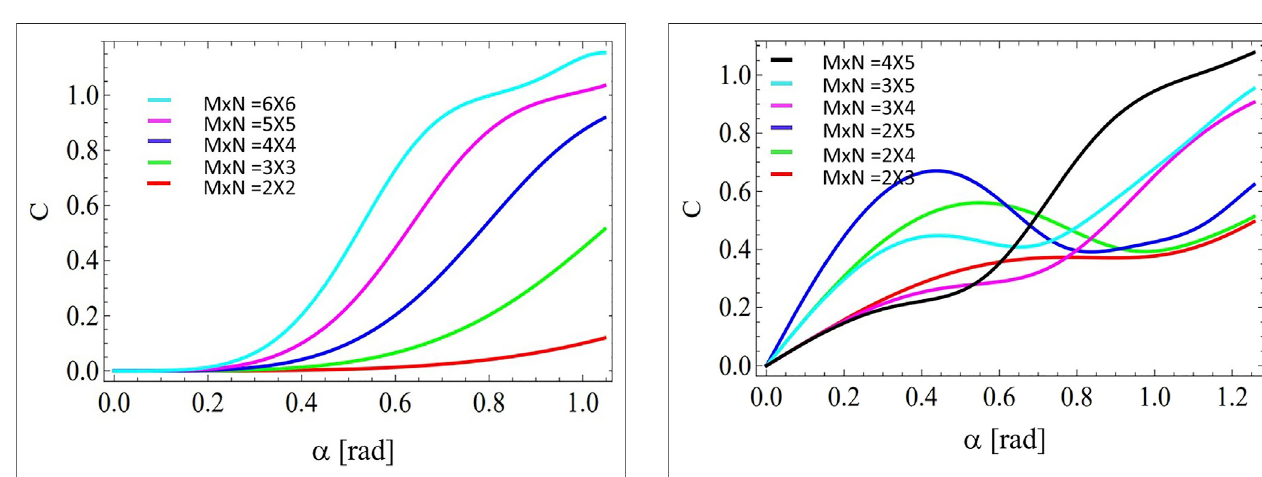
FIGURE 4 | Concurrence vs. angular aperture size for different path dimensions( M × N ) and aperture sizesinthe range [0, 2 π / N max ] with N max = 5. Details are in the text.